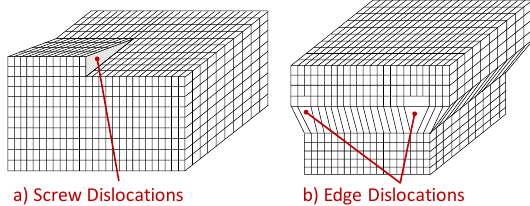
Figure 7. Illustration of linear defects: ( a ) Screw dislocation and ( b ) Edge dislocation. Kirchheim [29] evaluated the interaction energy of hydrogen in palladium edge dislocations. He found that the closer the core of the edge defect, the larger the interaction energy, which includes a self H-H attractive interaction energy. Far from the cores, the H-H interactions do not provide an appreciable contribution and, in general, the attractive interaction energy decreases with the reciprocal of the distance. Anyway, the additional population of hydrogen can be measured only at very small quantities of dissolved hydrogen due to the attractive interaction with edge dislocations. When carbon embeds in α -Fe, it leads to tetrahedral distortions causing attractive interactions towards screw dislocations. On the contrary, the octahedral positions occupied by the H-atoms in palladium make it interact with this type of dislocation at negligible or null levels [29]. The two-dimensional or planar defects include several forms of dislocations. Overall, stacking faults, grain boundaries and internal surfaces of micro-voids and micro-cracks are mentioned. To explain the stacking fault phenomenon, one can consider the case of the crystalline structure of two common lattices, the FCC and the HCP structures, for which the former can be oriented in two different planes, i.e., square or triangular, whereas the latter can be seen in the triangular orientation. In particular, one can imagine the crystal structure as a sequence of stacks. If A indicates the triangle, whereas the FCC structure as an ABC sequence. With this in mind, a stacking fault occurs, for example, when an unpredicted C-layer is present in the AB sequence of the HCP structure or when